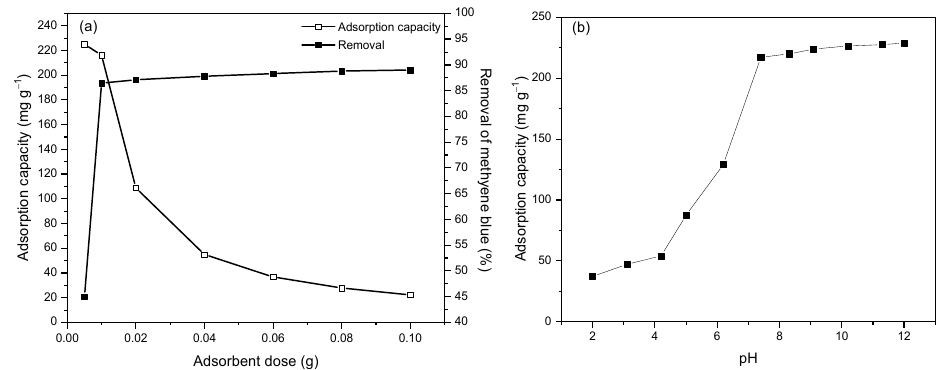
Figure 3. Effect of ( a ) adsorbent dosage and ( b ) pH on the adsorption capacity of methylene blue using CXTi synthesised in this study (T = 23 °C, adsorbent dose = 0.01 g, C 0 = 100 mg L − 1 ). Additionally, for optimum adsorption performance, it is important to determine a suitable operating pH, since this affects the surface charge and ionisation of pollutant molecules, while unfavourable adsorption, dissolution and decomposition lead to low adsorption uptakes [21]. Figure 3b shows the effect of pH on the adsorption of MB by CXTi, as a function of pH value. The adsorption capacity of MB at acidic pH ( ≤ 6) was low, which may be due to the positively charged sample surface repelling the cationic MB dye molecules. At higher pH values, i.e., more basic, in the range of 8–12, the interface of CXTi is negatively charged, which means it can favourably adsorb the cationic MB